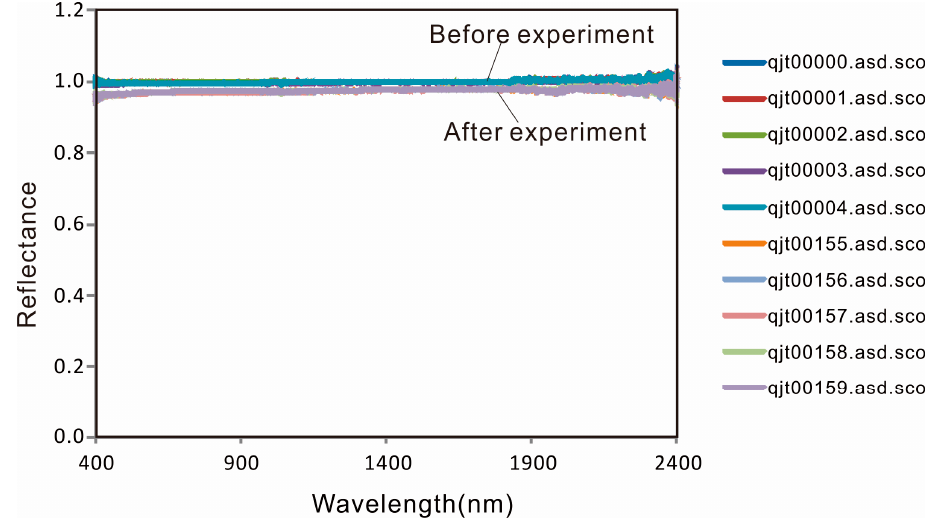
Figure 3. Spectral of white reference before and after the experiment.